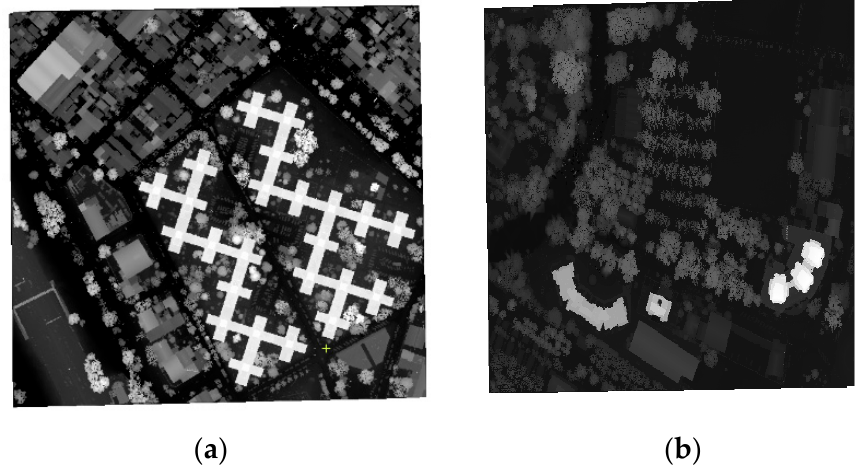
Figure 10. Ground truth LiDAR DSM data: ( a ) test site 1, ( b ) test site 2.